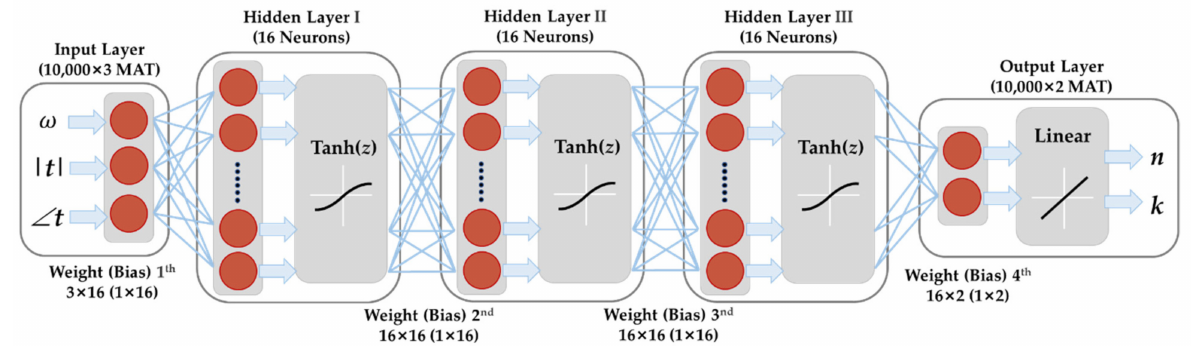
Figure 2. Schematic diagram of the optimal 4-layer neural network